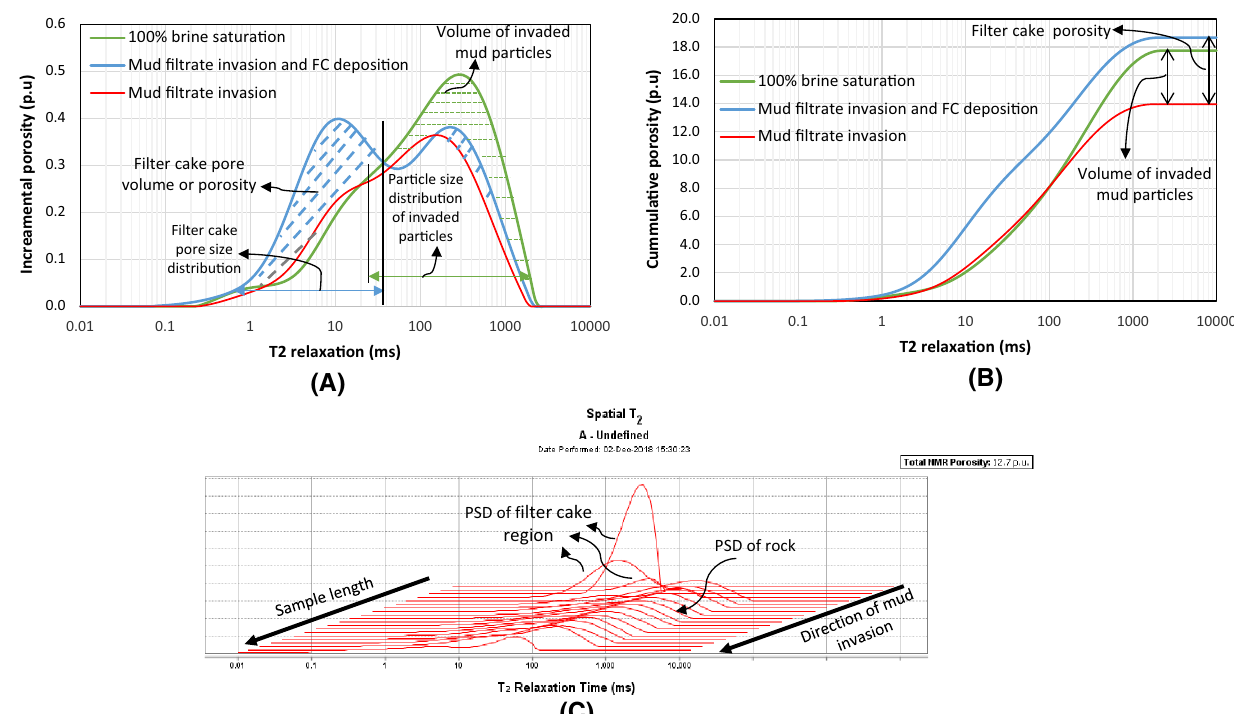
Fig. 7 Sample 1 A PDF of NMR T responding cumulative pore sizes (porosity) for the different sample 2 relaxation showing the pore size states. C The spatial pore size distribution along the sample distribution at 100% KCl saturation (green), after mud invasion and filter cake deposition (blue), and after removal of filter cake. B Cor-